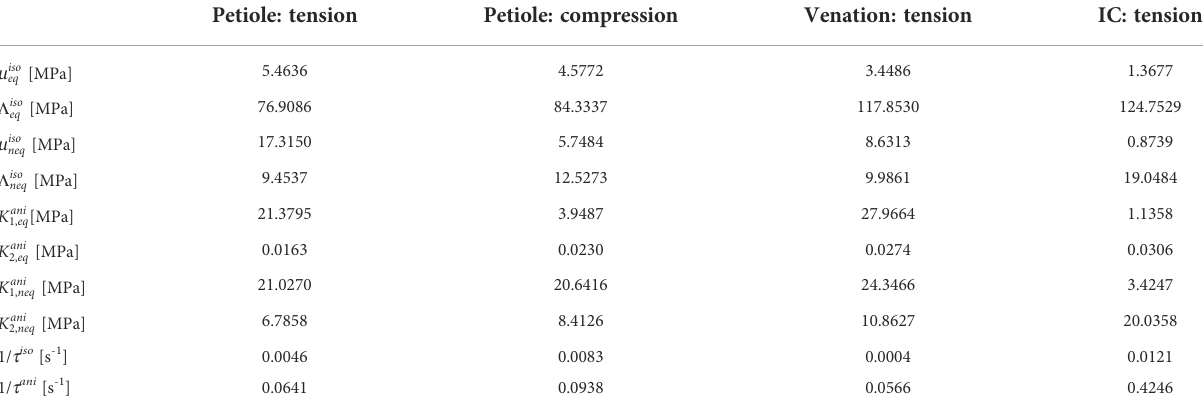
TABLE 2 Fitted parameters of the transversely isotropic viscoelastic material model. Petiole: tension Petiole: compression Venation: tension